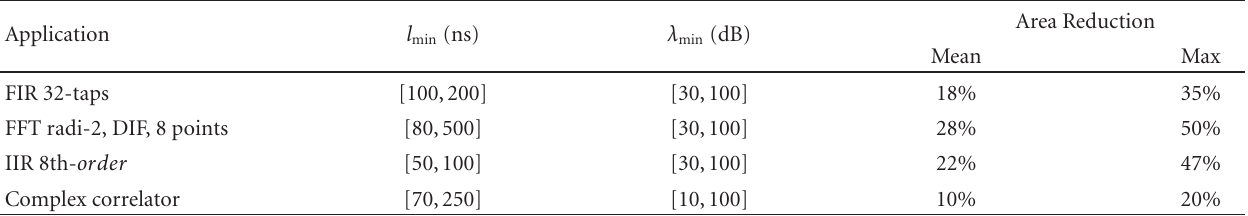
Table 3: Area reduction obtained after several iterations compared to the first iteration. Mean and maximal values obtained for di ff erent accuracy and timing